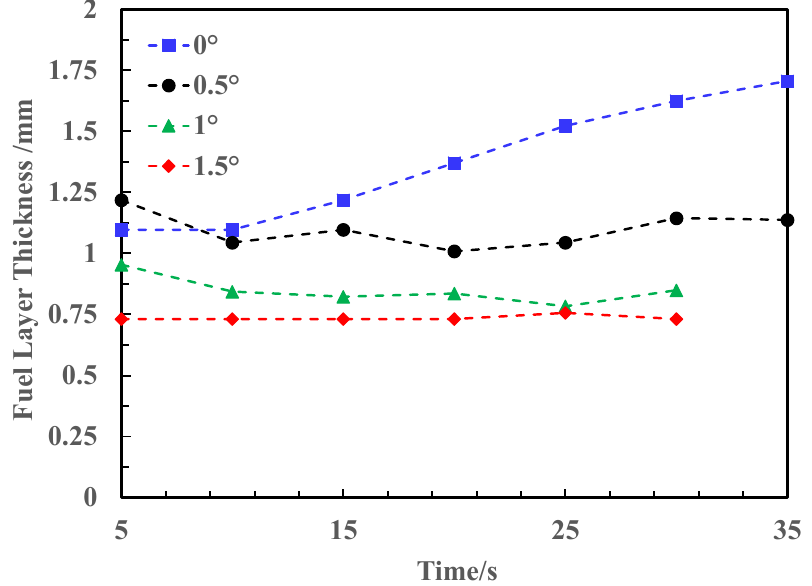
Figure 12. Variation of n-heptane oil layer thickness with a slope and on a non-ignition condition. Assuming the oil flow is stable and uniform when the thickness of the oil layer is close to h m , the Manning formula can be used to describe the relationship between slope and h m . The Manning formula is: